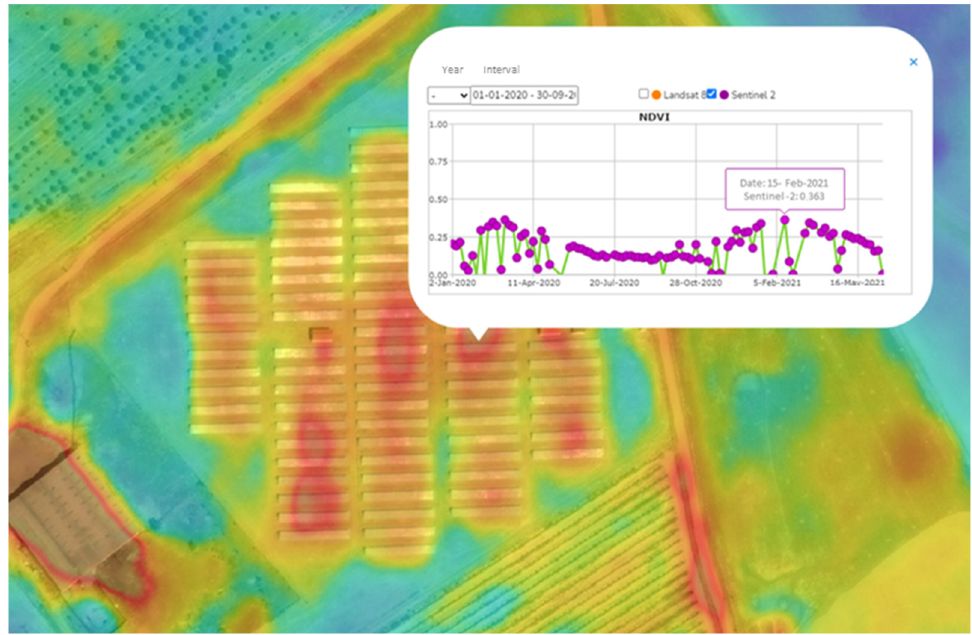
Figure 5. NDVI image display example of a photovoltaic solar plant for a given specific moment and the corresponding graph showing the NDVI variation over time for the selected pixel.